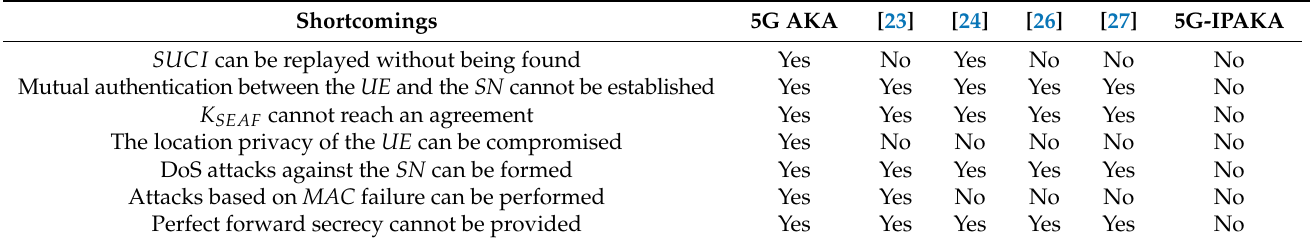
Table 1. Comparative analysis between the 5G-IPAKA protocol and the recently improved 5G AKA protocols [23,24,26,27] regarding the shortcomings of the latest version of the 5G AKA protocol.